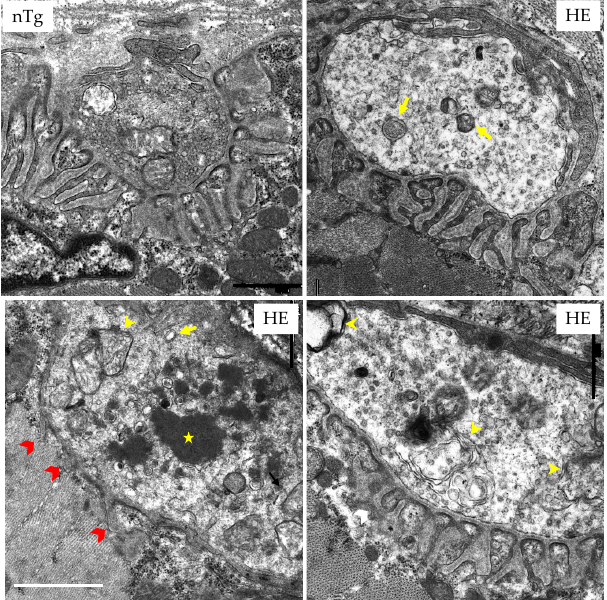
Figure 5. NMJs of HE mice display ultrastructural abnormalities at 18 months of age. EDL were prepared for conventional electron microscopy. Characteristic pictures are shown. In nTg mice, nerve terminal contains numerous small clear synaptic vesicles and mitochondria located in the more proximal portion of the terminal. The postsynaptic membrane has deep junctional folds. In HE mice, the density of synaptic vesicles is decreased in the pre-synaptic terminal that contains enlarged endosomes (yellow arrows), autophagosomes (yellow arrowheads), and electron-dense structures (white star). The post-synaptic folds are occasionally reduced (red arrowheads). Scale bar: 1 µm.